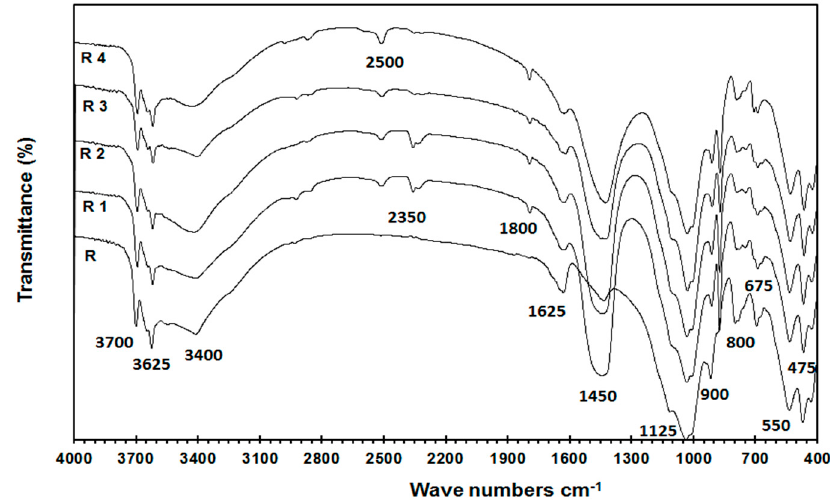
Figure 9. FTIR spectra of the specimens of different mixes that were cured for four weeks.